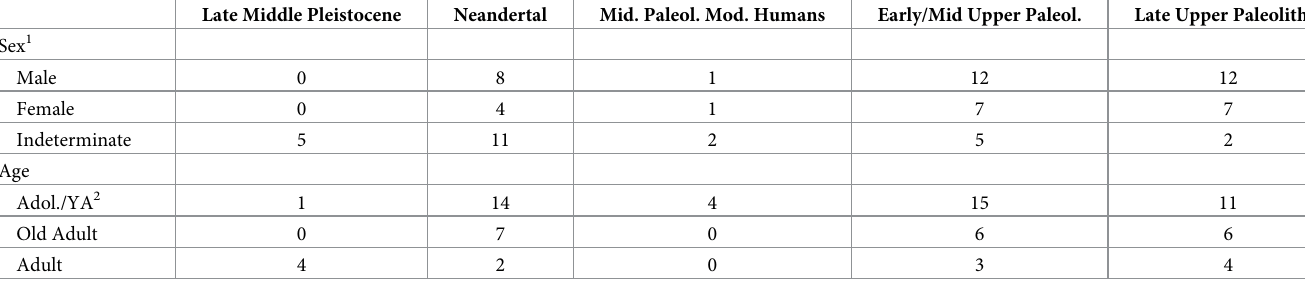
Table 2. Sex and age distributions for the late Middle and late Pleistocene samples. Late Middle Pleistocene Mid. Paleol. Mod. Humans Early/Mid Upper